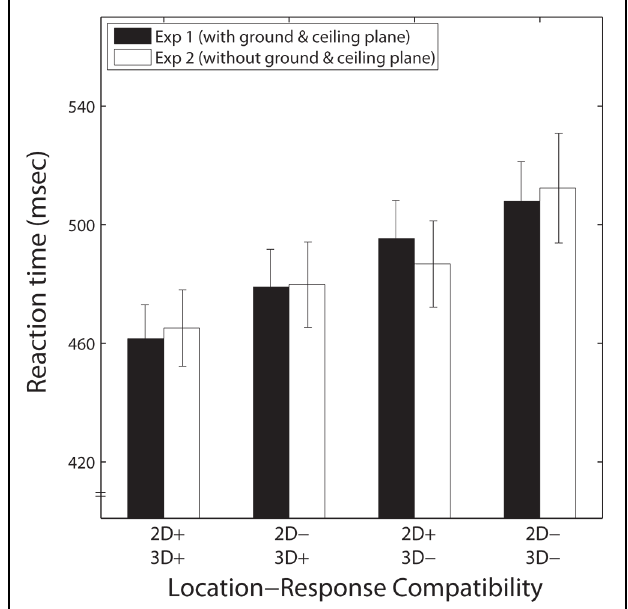
FIGURE 4 | Mean reaction times (RTs) for Experiment 1 (black bars) and Experiment 2 (white bars) as a function of location-response compatibility. Error bars indicate SEs . The symbol ‘ + ’ indicates compatibility between the stimulus location and response, and ‘ − ’ means